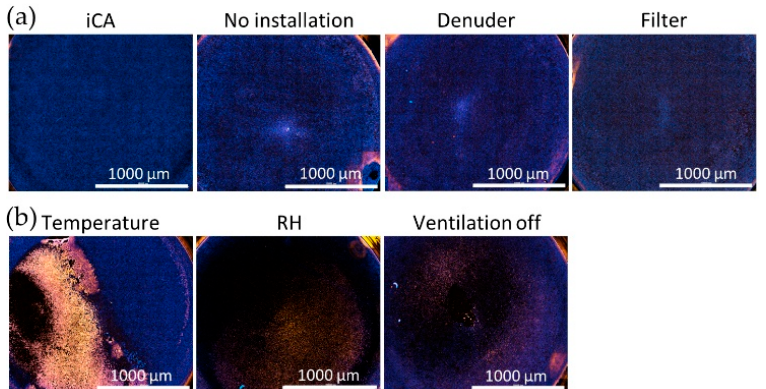
Figure A3. Optimization of parameters crucial for the integrity of the ALI monolayer during cell exposures. ( a ) Intact ALI cell layer when all parameters are accordingly adjusted. Neither activated carbon denuder, nor glass fiber filter installations affect the ALI cell layer. ( b ) From left to right: ALI cell layer impairment if no external module tempering is applied, RH % is insufficient, and the ventilation engine is turned off.